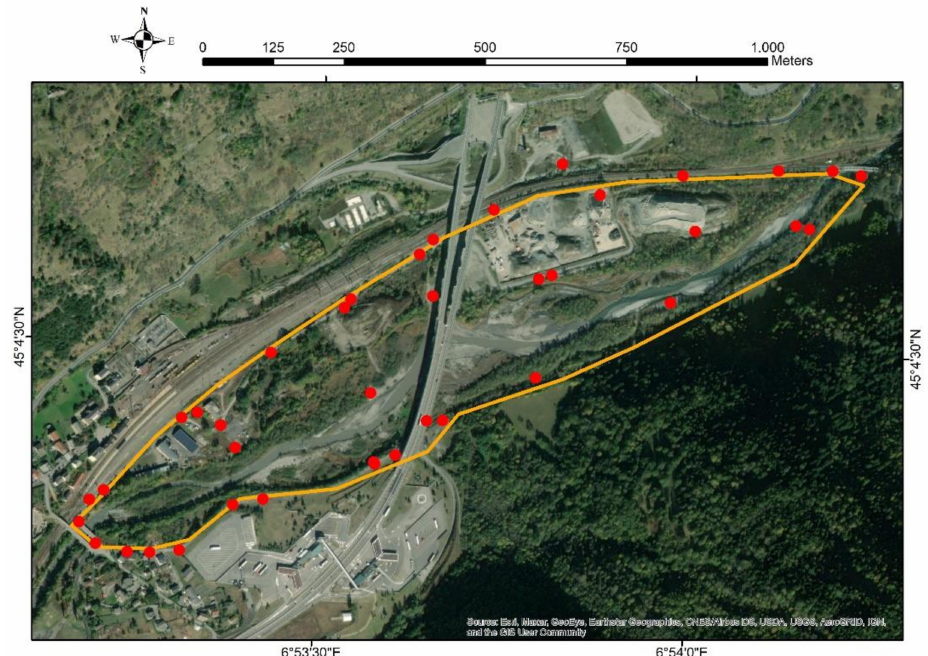
Figure 3. The overall topographic points location (see the red dots) within the study area (see the orange